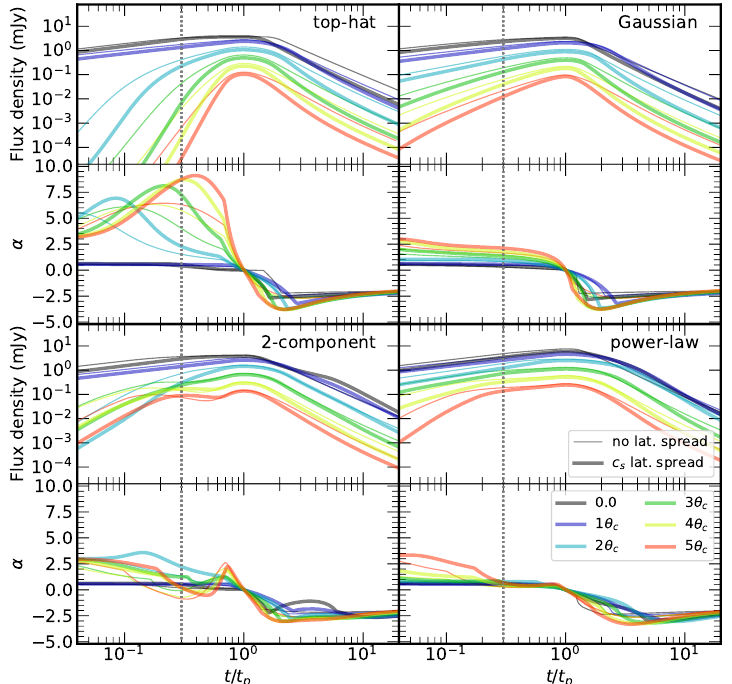
Figure 1. Lightcurves and temporal index, α , evolution relative to the lightcurve peak time for four jet structure profile models. Different line colours indicate the line-of-sight angle from the jet central axis. Line width indicates whether lateral spreading is included or not; a thin line without spreading, and a thick line with sound speed spreading. The vertical grey dotted line indicates t = 0.3 t p , and is the time used to show the change in α with inclination.